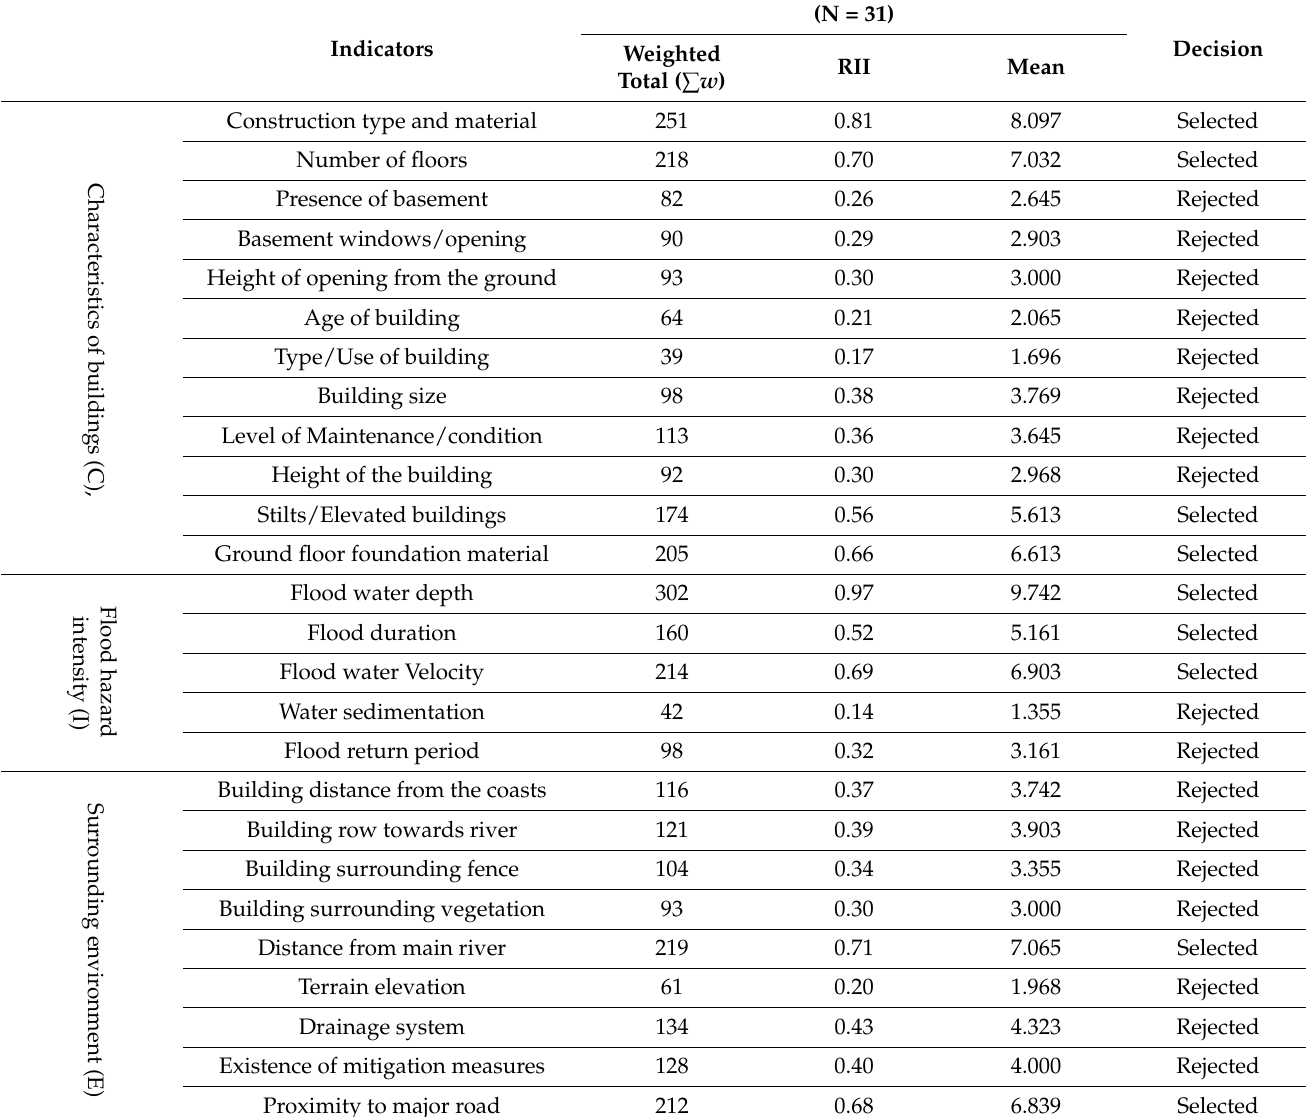
Table 2. Expert opinion agreement on physical flood vulnerability